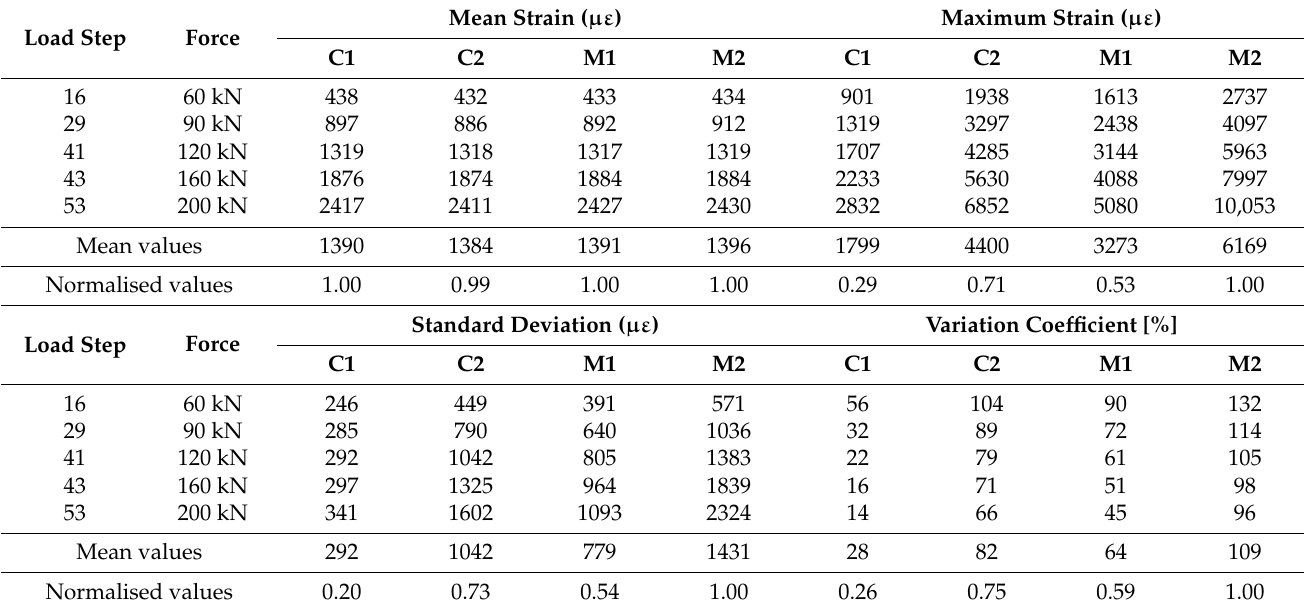
Table 3. Global statistical parameters (mean, maximum, standard deviation, and variation coefficient) for all investigated DFOS tools in selected load